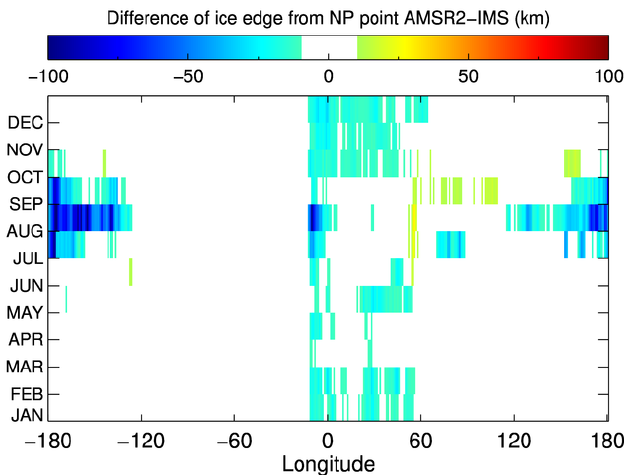
Figure 11. Differences of monthly median ice edges from AMSR2 and IMS from 2015 to 2019 Figure 11. Di ff erences of monthly median ice edges from AMSR2 and IMS from 2015 to 2019 according according to longitude. Absolute differences of less than 10 km are in white. to longitude. Absolute di ff erences of less than 10 km are in white.